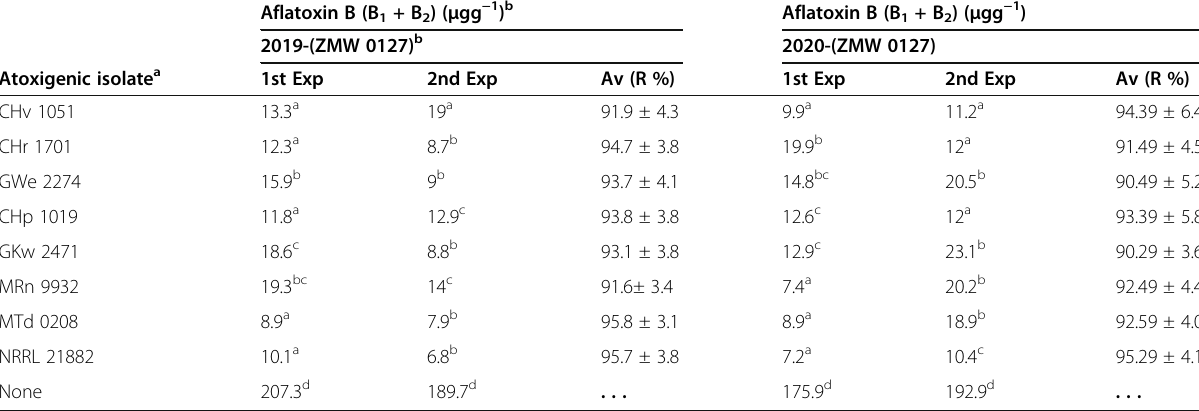
Table 2 Competitive exclusion and efficacy of atoxigenic Aspergillus section Flavi against toxigenic L